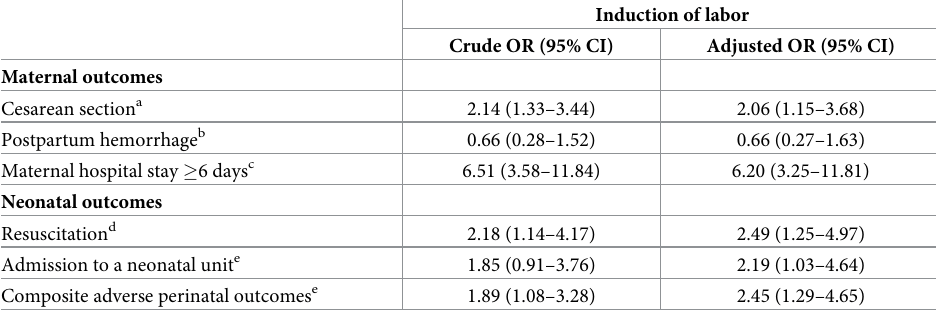
Table 4. Association between maternal and neonatal outcomes and induction of labor.